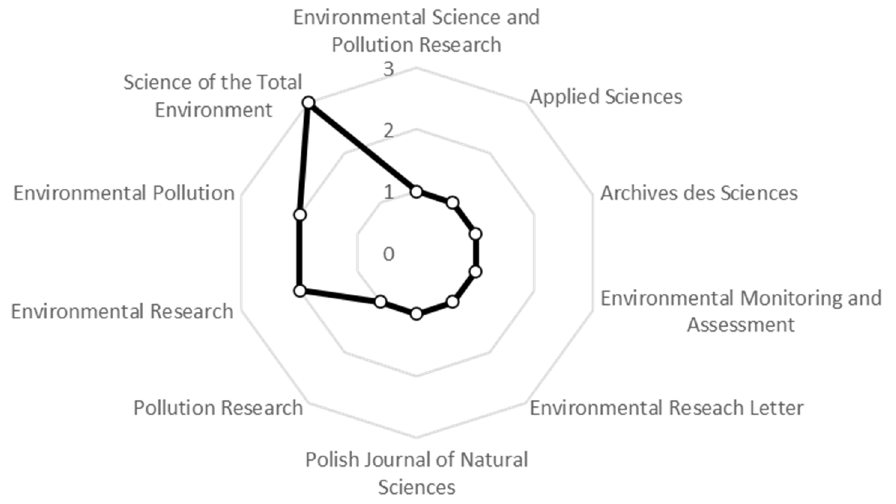
Figure 2. List of journals ordered by number of articles published.